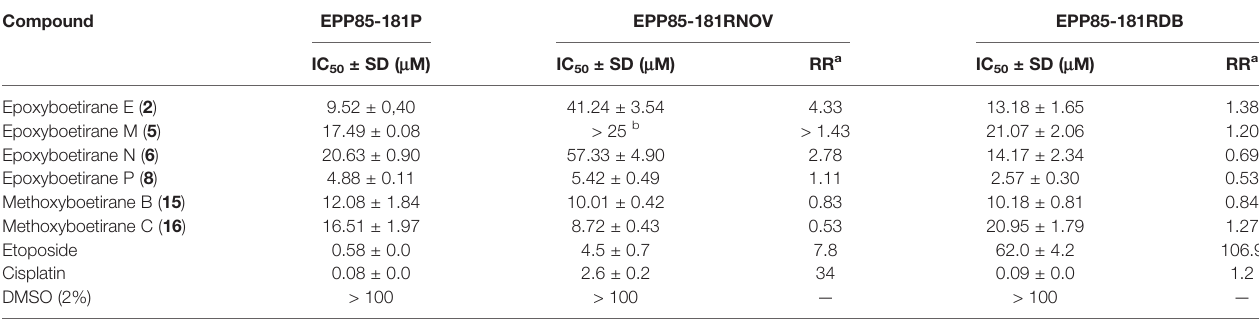
TABLE 3 | Antiproliferative activity of 1 – 16 in in pancreatic carcinoma cells: EPP85-181P (parental), EPP85-181RNOV (multidrug resistance [MDR] phenotype), and EPP85-181RBD (multidrug resistance [MDR] phenotype).